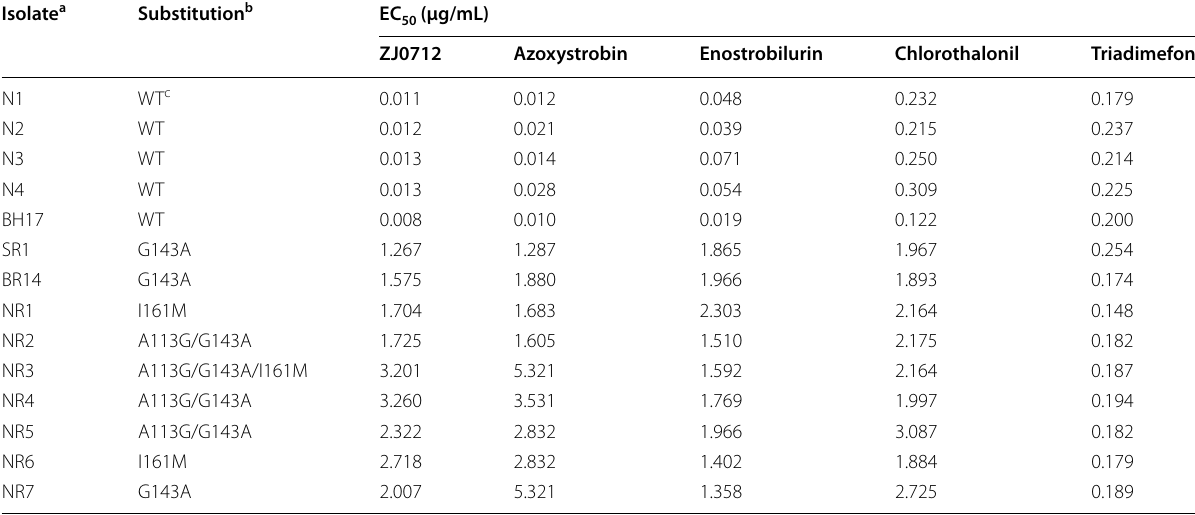
Table 3 Amino acid substitution in Cyt b and sensitivity of Podosphaera xanthii isolates or mutants to ZJ0712 and four other fungicides Isolate